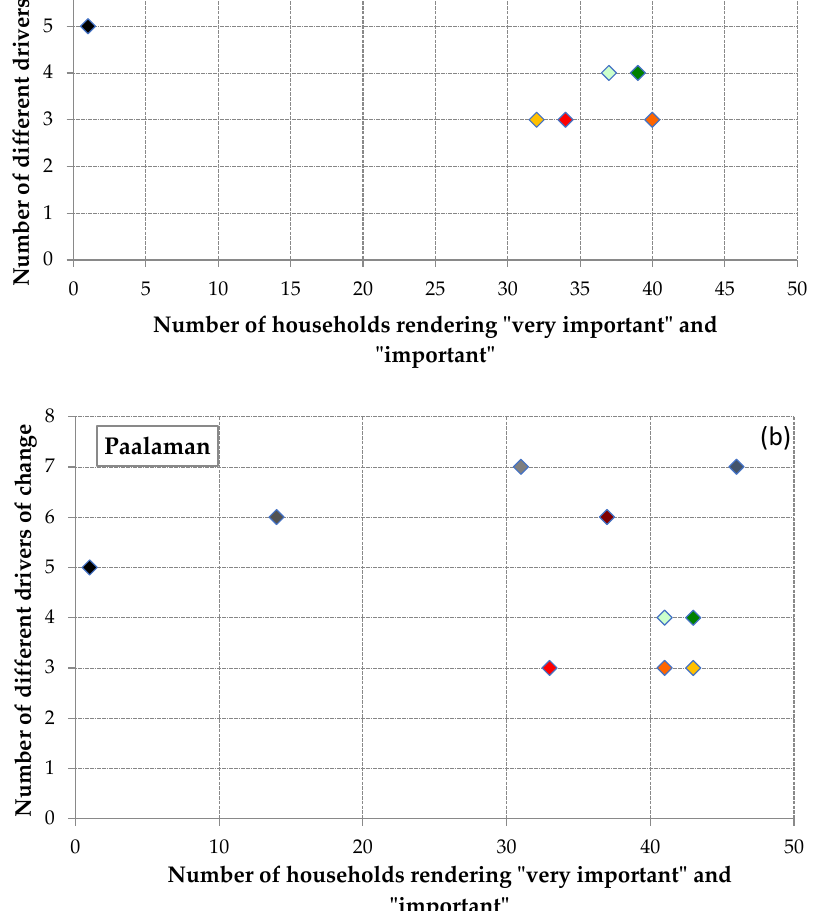
Figure 6. The relation between drivers of change and importance values attached to ecosystem services (ES) by local resource users in the two villages, ( a ) Special district (N = 42) and ( b ) Paalaman (N = 48). The colors denote different provisioning services (See Table 3 for details). Table 3. Drivers of change of different provisioning services available in the two villages.